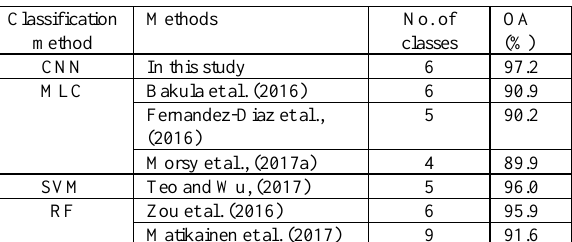
Figure 8. Predicted maps of different CNNs with Combination 4. Table 6. Comparative study and